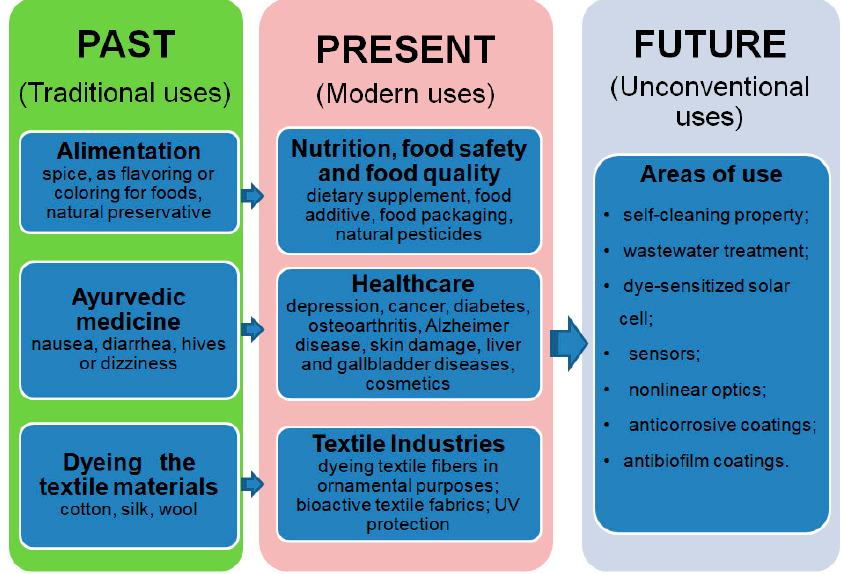
Figure 2. Areas of use of curcumin.